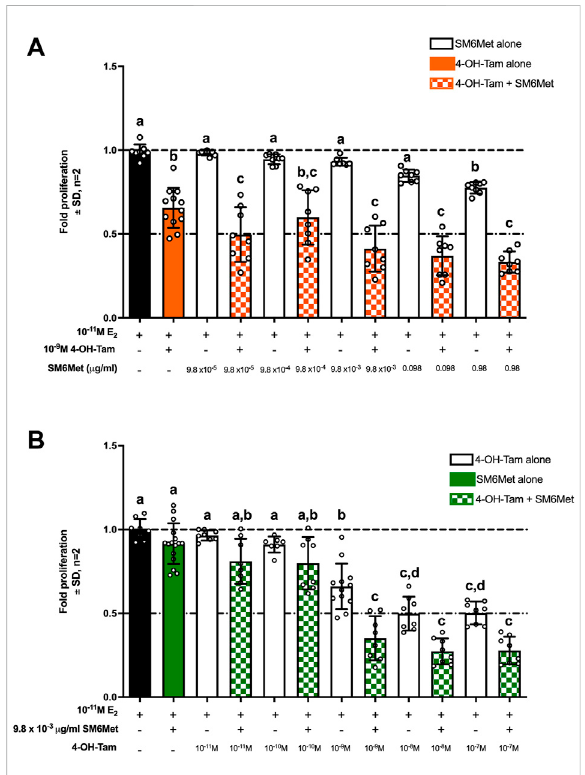
FIGURE 1 Combinatorial MTT assay for the effect of 4-OH-Tam combined with SM6Met on breast cancer cell proliferation. (A) MCF7BUS cells were induced with increasing concentrations of SM6Met combined with a constant concentration of 4-OH- Tam, in the presence of 10 – 11 M E 2 , for a period of 7 days, wherein there were two re-treatments. (B) MCF7BUS cells were treated with increasing concentrations of 4-OH-Tam combined with a constant concentration of SM6Met, in the presence of 10 – 11 M E 2 , for a period of 7 days, wherein there were two re-treatments. Thereafter, viable cells were determined using the MTT assay. Average ± SD is of two independent biological experiments done in quadruplicate. The results were expressed as fold proliferation relative to the positive control, 10 − 11 M E 2 , which is set at 1. See Supplementary Figure S2 for results from solvents and E 2 and Supplementary Figure S3 for a progress curve with E 2 . Statistical analysiswasperformedusingone-wayANOVAanalysisofvariance with Tukey ’ s multiple comparisons test as post-test, where different letters indicate statistically signi fi cant differences at p < 0.05. Bars with common letters are not signi fi cantly